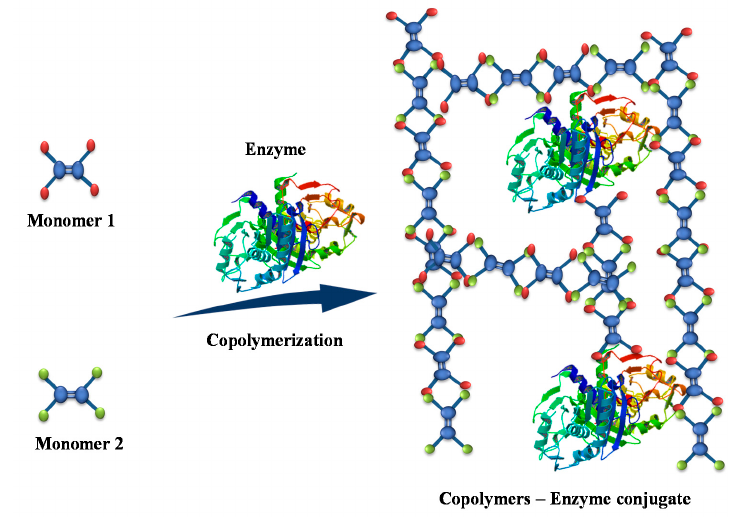
Figure 1. Schematic representation of enzyme immobilization via copolymerization.